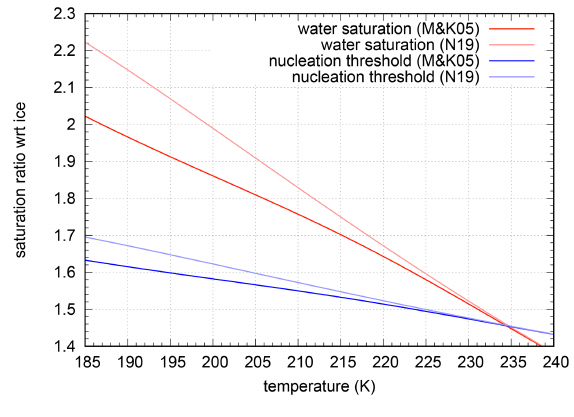
(cid:16) (cid:17) p liq S i = and nucleation thresh- p ice